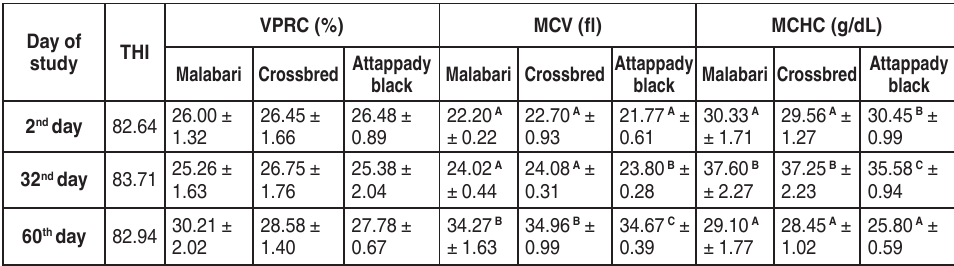
table 4. Mean ± SE of VPRC, MCV and MCHC of Malabari, crossbred and Attappady black goats Day of